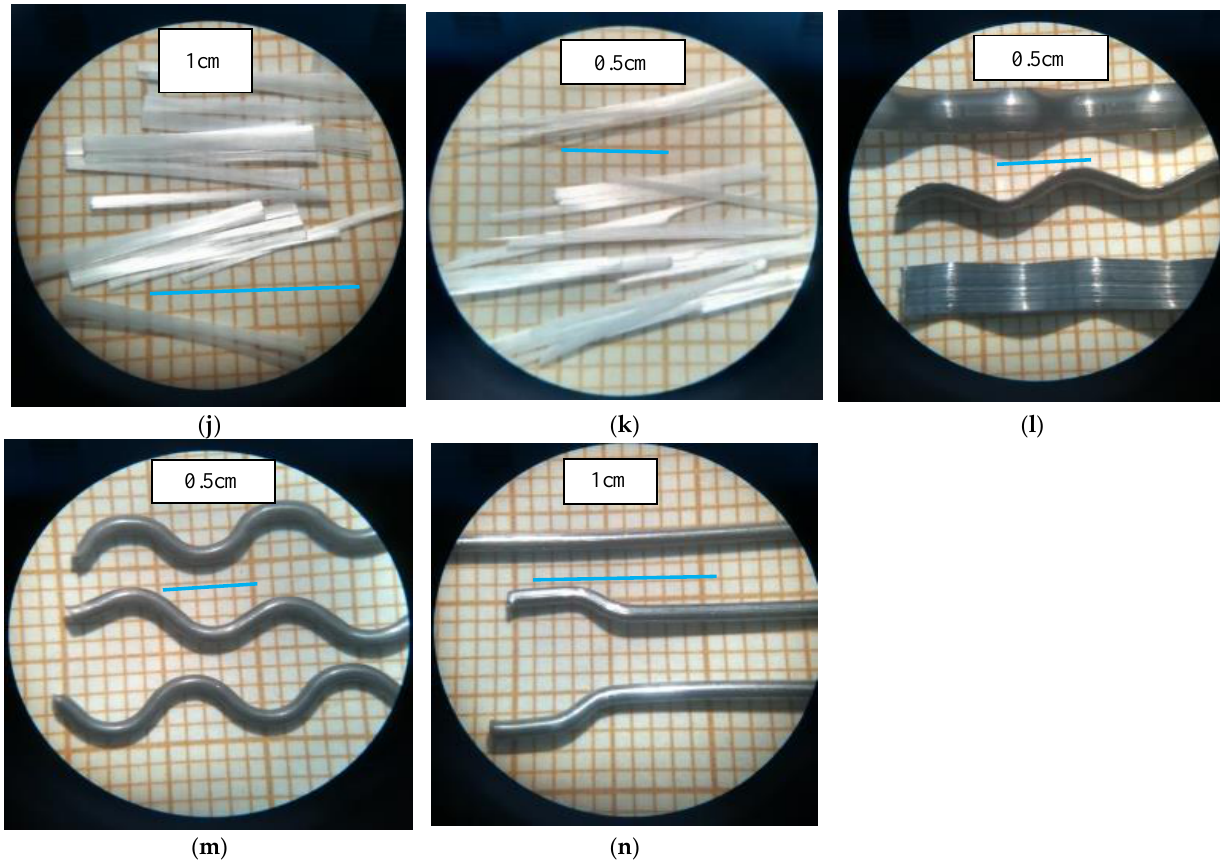
Figure 9. Type of fibers used in this research. Polypropylene fibers: ( a ) ST30, ( b ) ST42, ( c ) NS12, ( d ) NS18, ( e ) CN54. Pneumatic fibers: ( f ) pneumatic textile fiber (rubber), ( g ) steel fibers from pneumatic. Glass fibers: ( h ) HD3 ( i ) HD6 ( j ) HD12 ( k ) HP. Metal fibers: ( l ) RW50+, ( m ) RW50, ( n ) MF-FP.